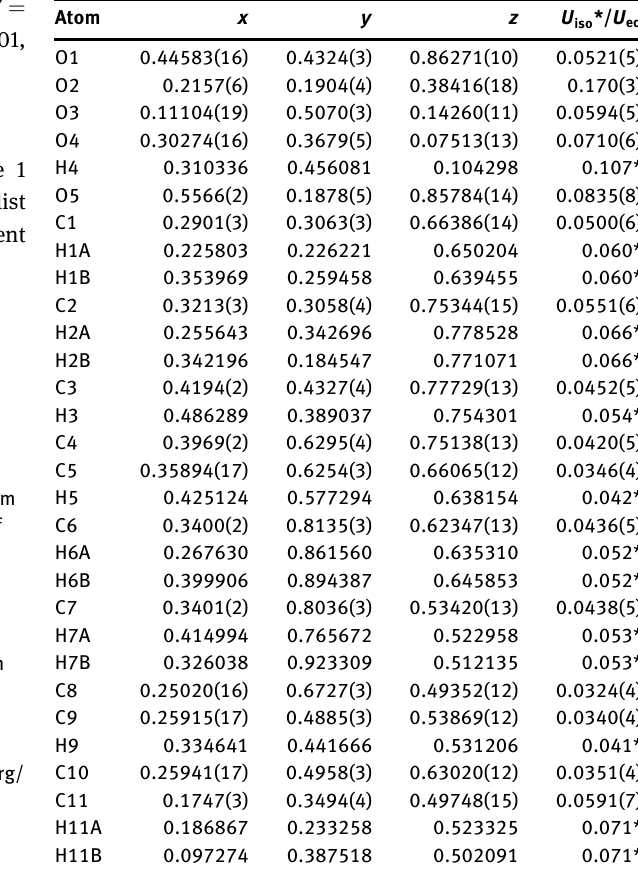
Table 2: Fractional atomic coordinates and isotropic or